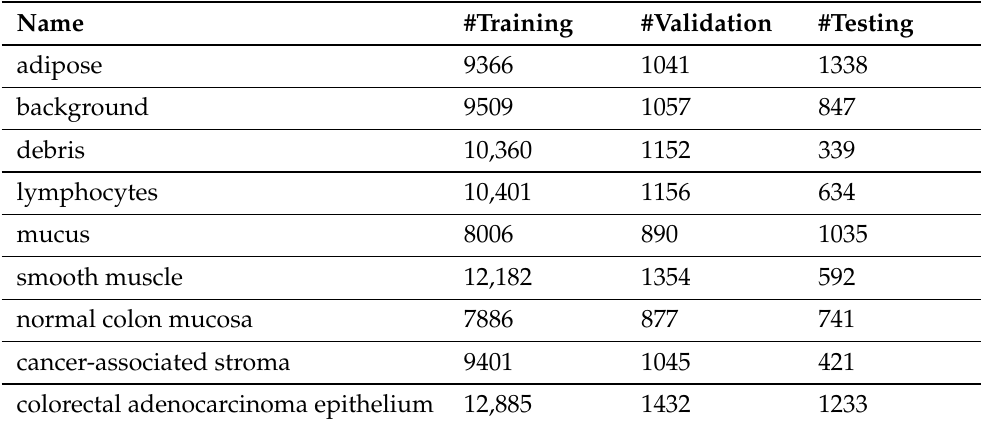
Table 2. Details of PathMNIST dataset.